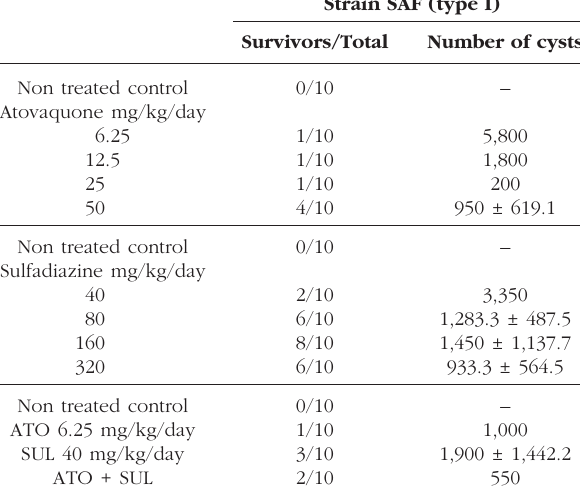
Table I. – Survival and number of brain cysts in mice infected with SAF strain of T. gondii and treated with different doses of atova- quone (ATO), sulfadiazine (SUL) or drug association (ATO +